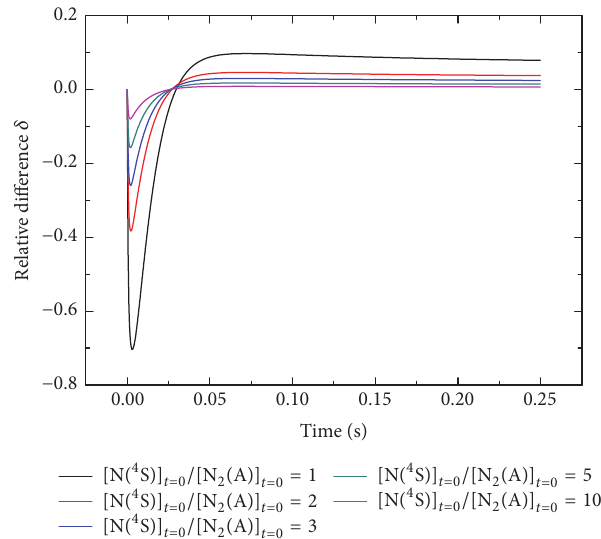
Figure 6: Relative difference 𝛿 between full (see ( 1 )–( 7 )) and reduced (see ( 1 ), ( 2 ), ( 3 ), and ( 7 )) models for several initial ratios between [N( 4 S)] and [N 2 (A)].